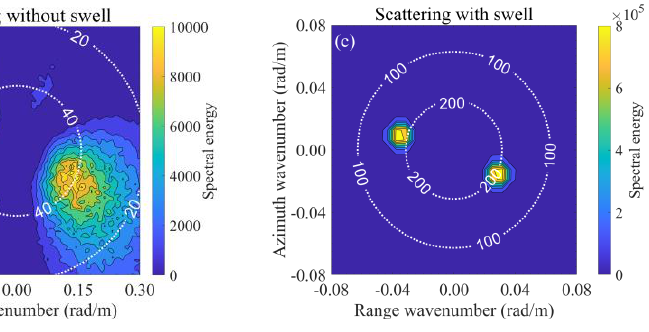
Figure 20. Similar to Figure 18 but corresponding to ID 2.